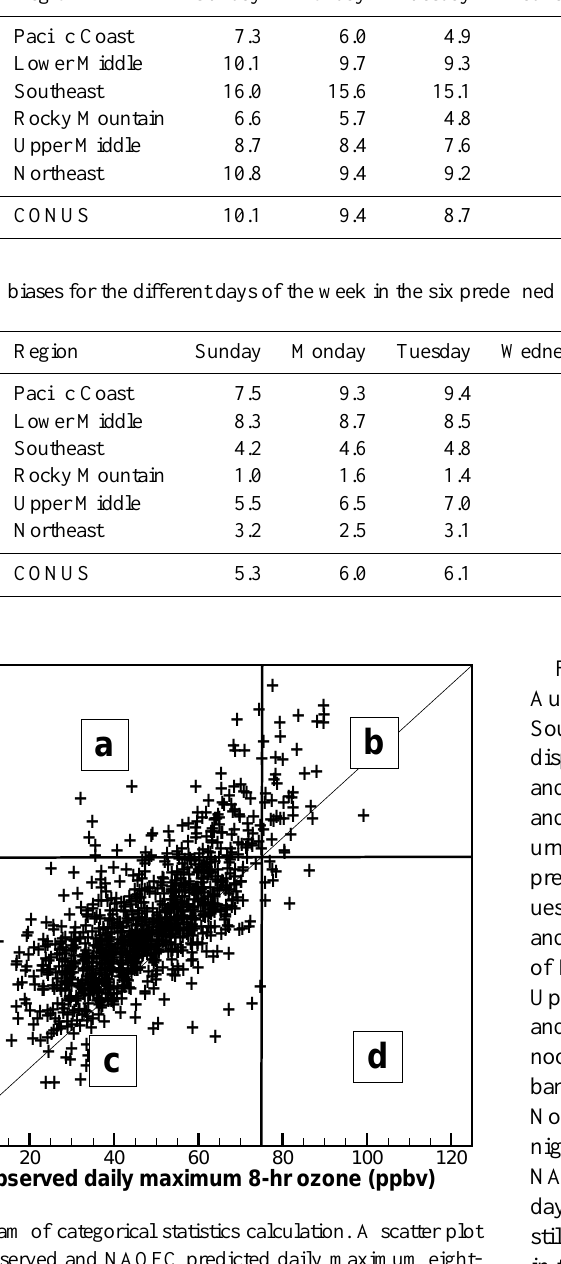
Table 7. Ozone biases for the different days of the week in the six predefined regions and CONUS. June–September 2010. Unit: ppbv. Region